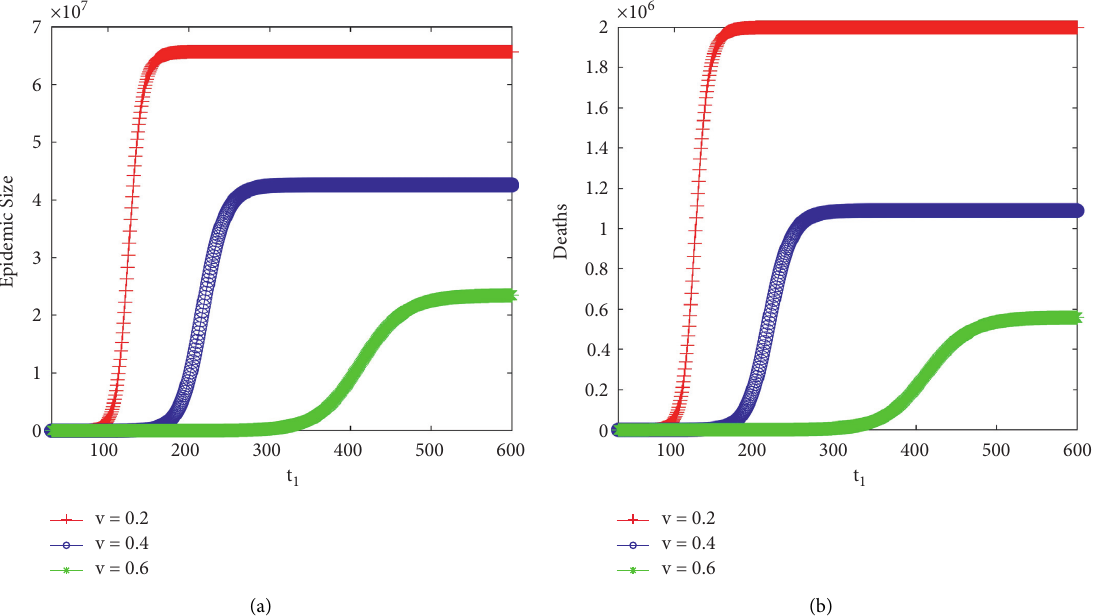
Figure 8: Diagnosis rates ] � 0 . 2 , 0 . 4 , 0 . 6 and measures intensity m � 0 . 8; the epidemic size and death number vary with the start time of taking measures. (a) Epidemic size; (b) death